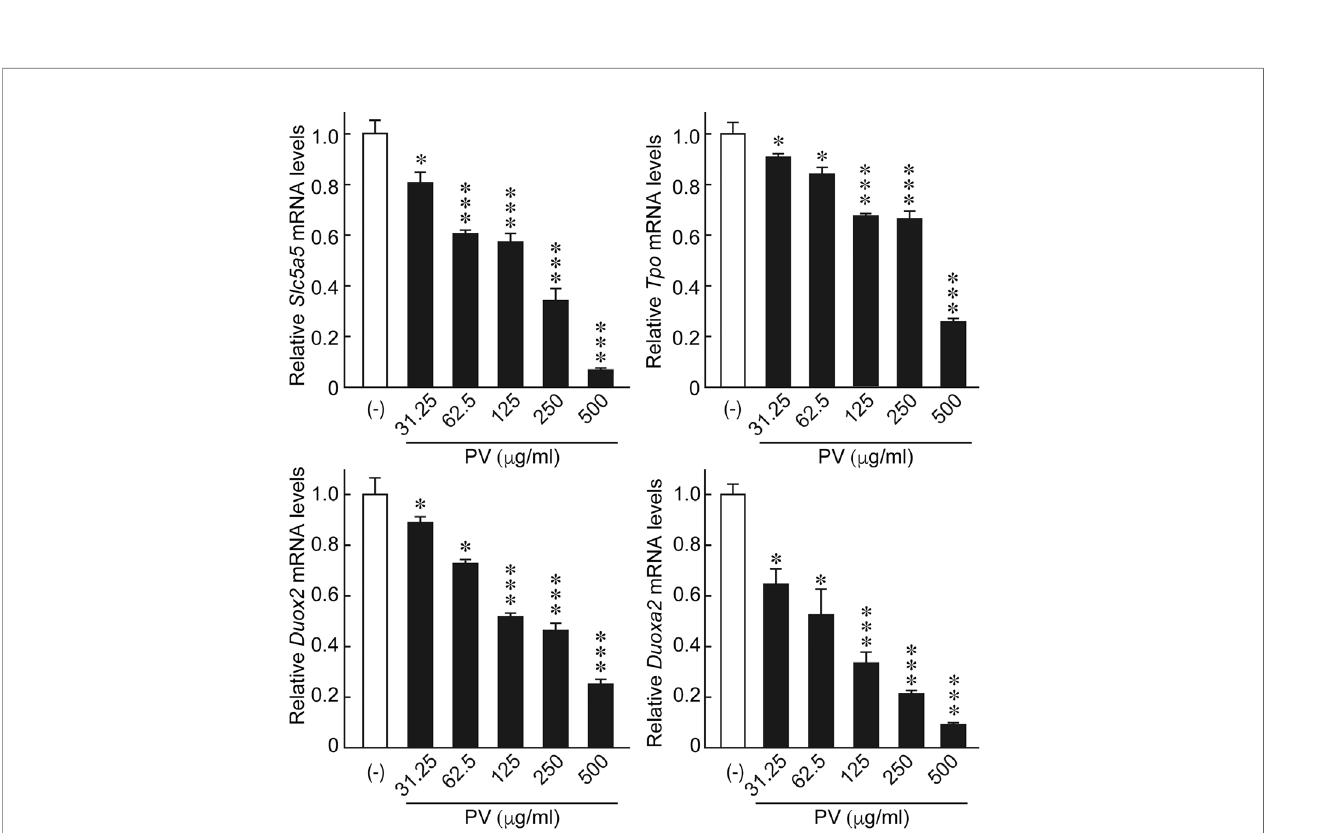
FIGURE 6 | PV suppresses the mRNA expression of genes essential for thyroid hormone biosynthesis. FRTL-5 cells were treated with PV at increasing concentrations (0, 31.25, 62.5, 125, 250, 500 m g/mL) for 24 h. Total RNA was puri fi ed from the cells and subjected to real-time PCR analysis to determine the relative mRNA expression levels of Slc5a5 , Tpo , Duox2 and Duoxa2 . mRNA levels were normalized against Gapdh levels and expressed as fold-change relative to the control. Data are presented as mean ± SD relative to the levels of PV (-) cells (n = 3). * p < 0.05 and *** p < 0.001, compared to PV ( − )